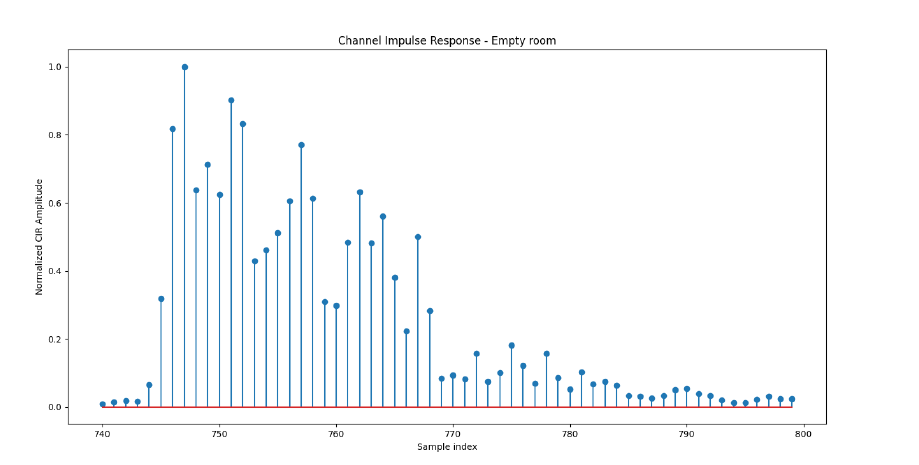
Figure 3. Normalized Channel Impulse Response, Room A, empty.